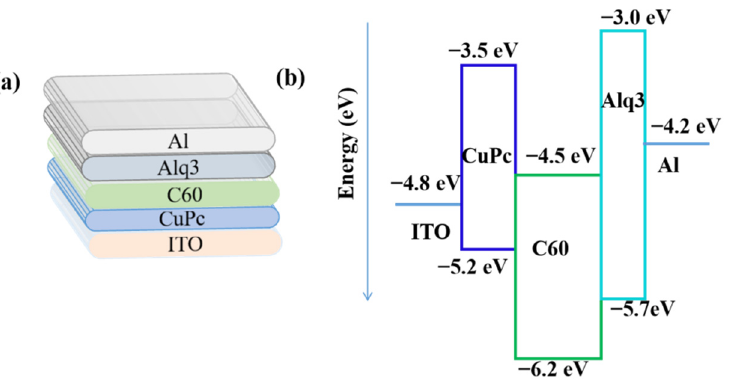
Figure 1. The device structure ( a ) and energy level ( b ) with ITO/CuPc (20 nm)/C60 (55 nm)/Alq3 (6 nm)/Al (100 nm).